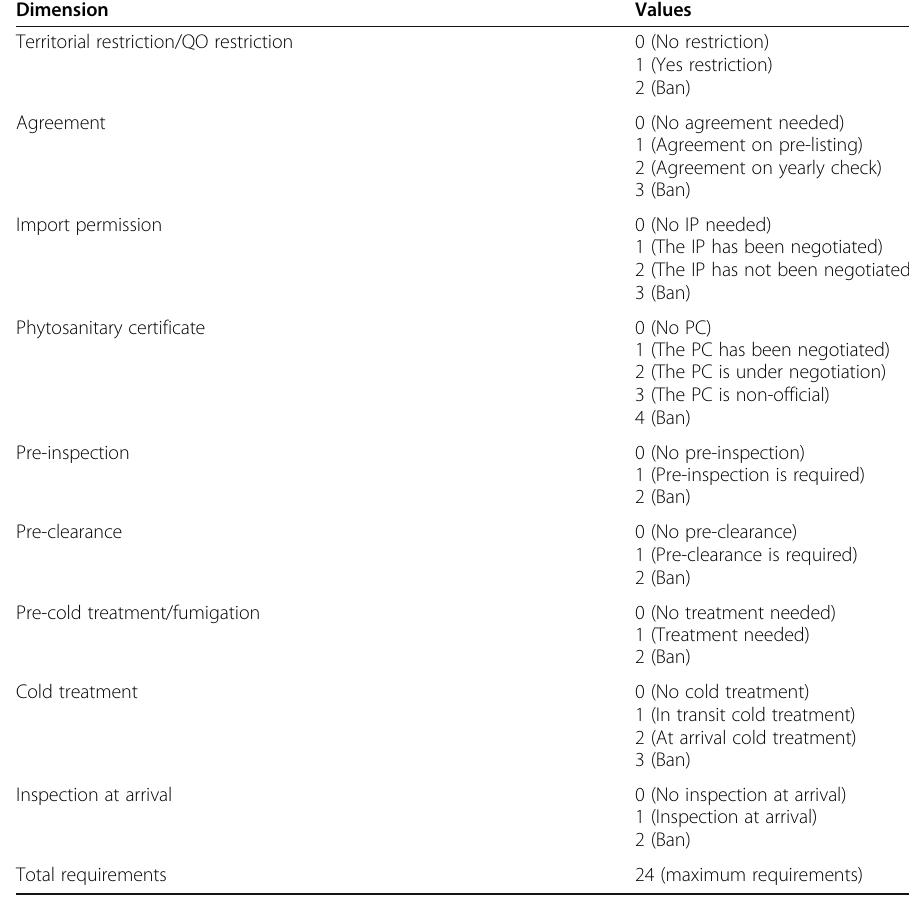
Table 5 Dimensions and grades of the phytosanitary requirements and underlying regulations Dimension Values Territorial restriction/QO restriction